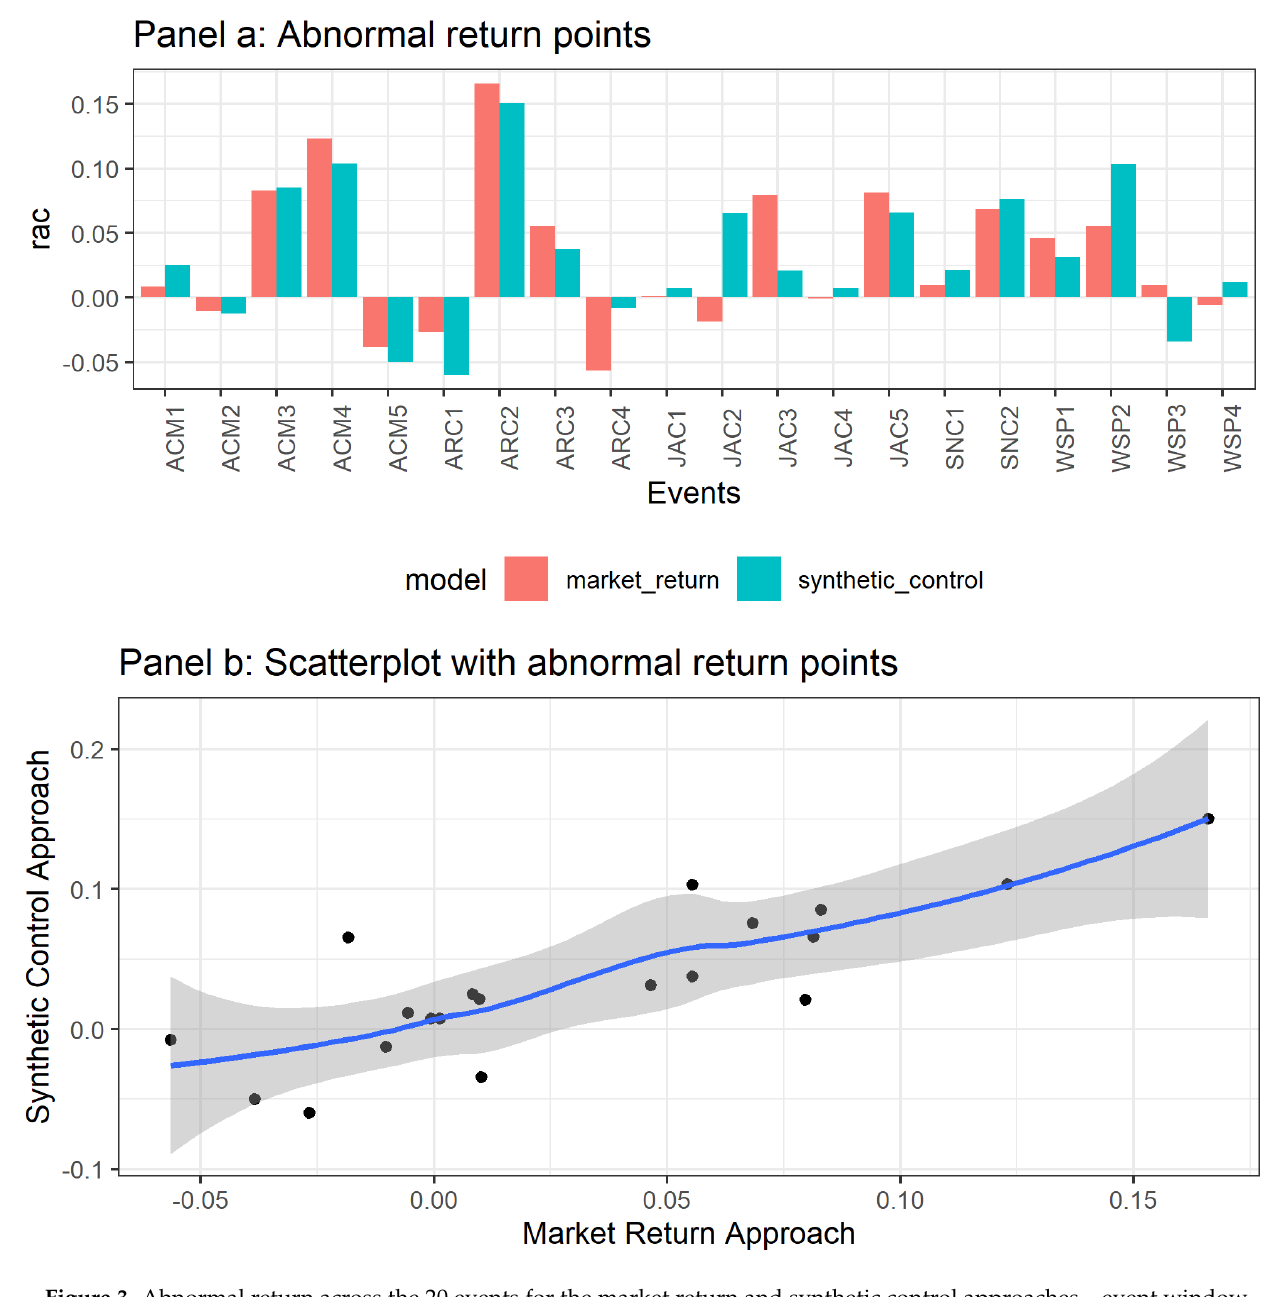
Figure 3. Abnormal return across the 20 events for the market return and synthetic control approaches—event window (−0 days, +10 days).